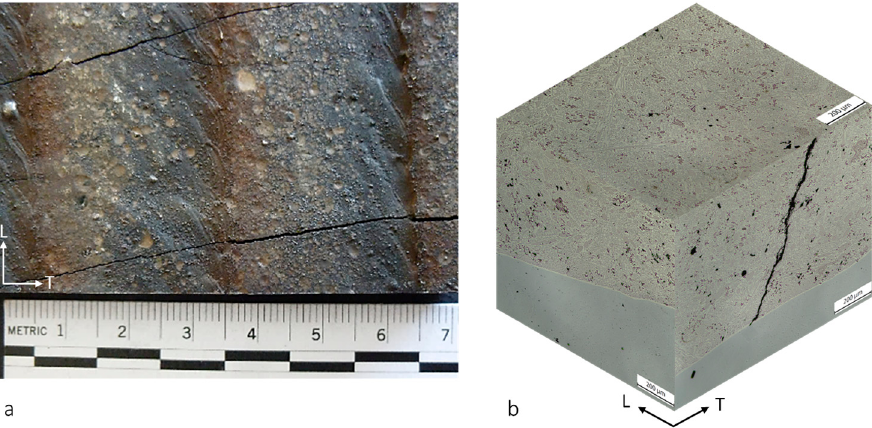
Figure 3. Hardfacing plate: ( a ) image of the resistant side of the wear plate; ( b ) 3D isometric optical micrographs of the unetched Fe-Cr-C alloy.